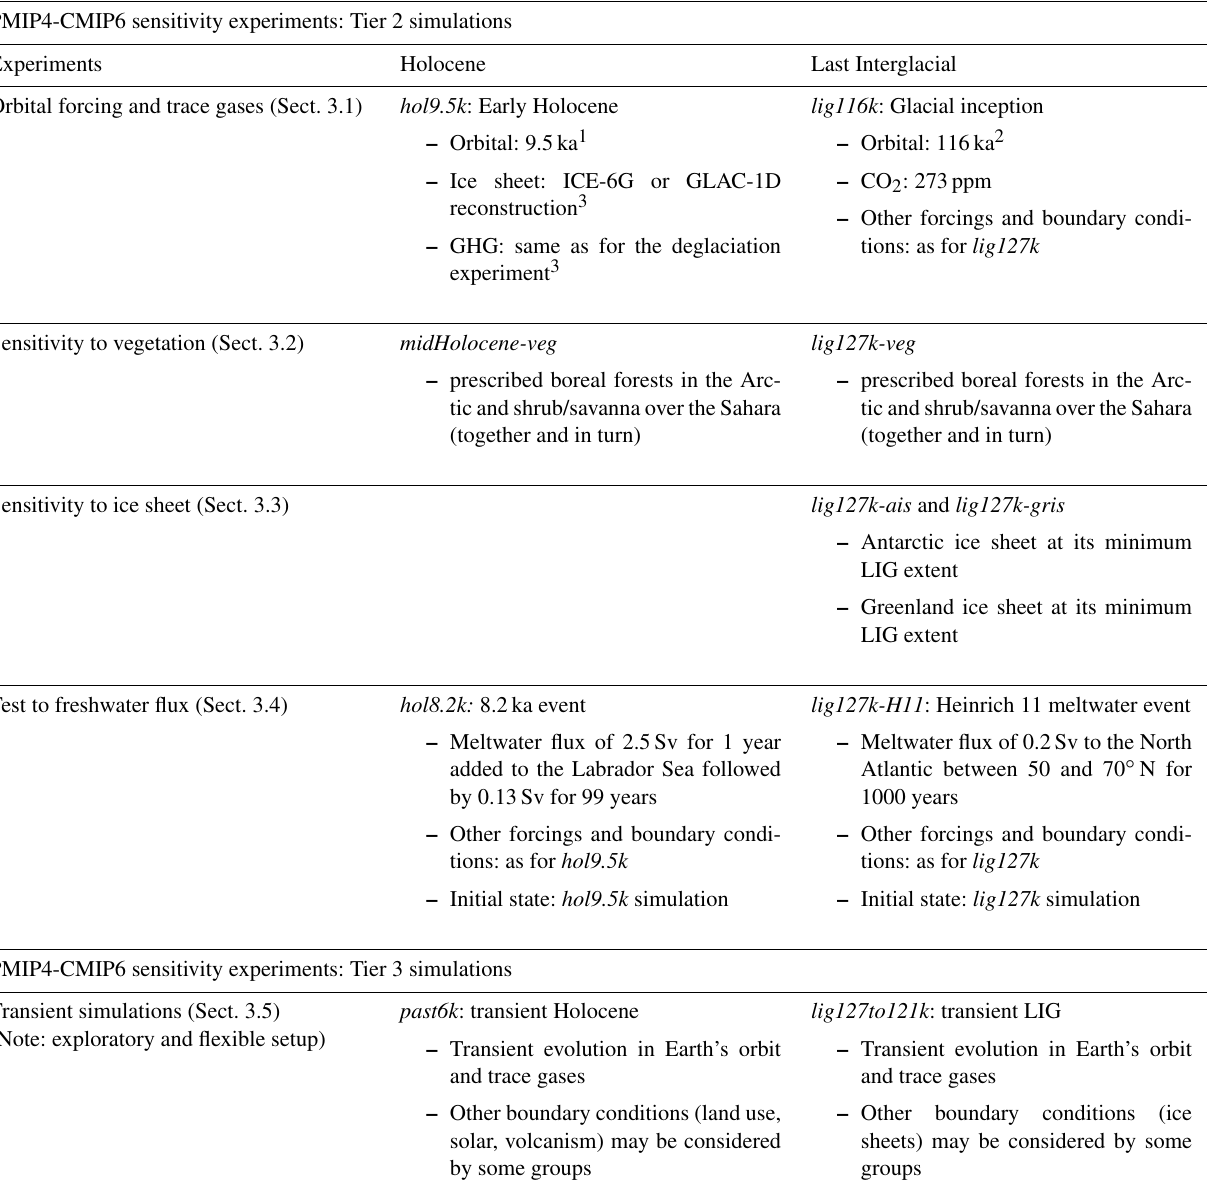
Table 2. Summary of PMIP4 Tier 2 and Tier3 sensitivity simulations complementing PMIP4/CMIP6 Tier 1 interglacial experiments. More details can be found in the section numbers indicated in